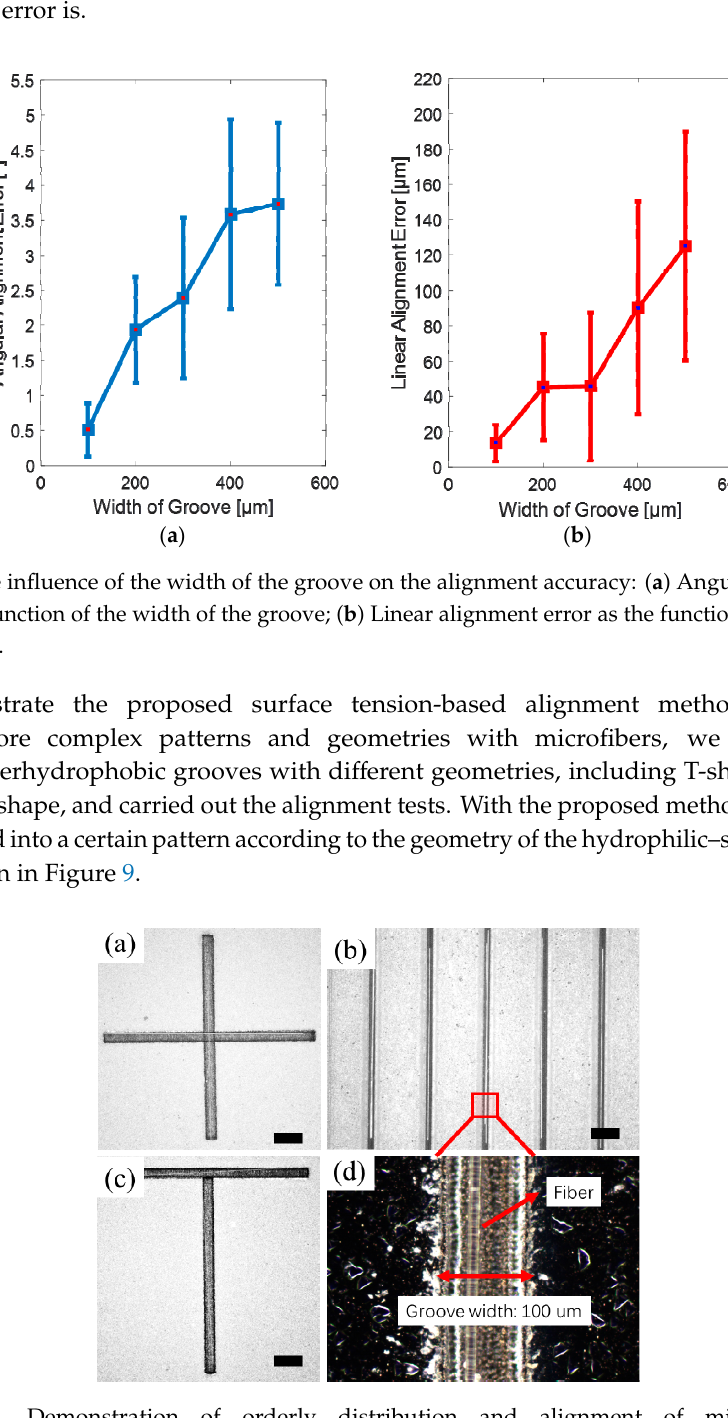
hydrophilic–superhydrophobic grooves: ( a ) Cross-shape distribution; ( b ) Parallel distribution; ( c ) T-shape distribution; ( d ) Zoomed image of a 100 µm wide groove with a 13 µm fiber inside. Scale bar: 400 µm. (Supplementary Video S1).